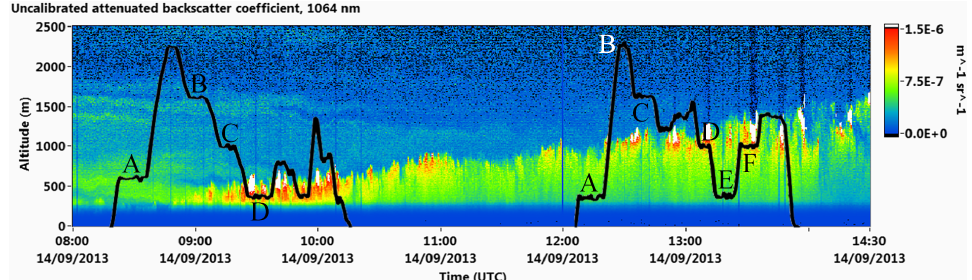
Figure 3. Range-corrected backscatter signal for 1064nm derived with Polly XT on 14 September. The more reddish, the larger is the backscatter signal. The black lines represent the flight patterns of flights 14a and b. White colors indicate very high backscattering.